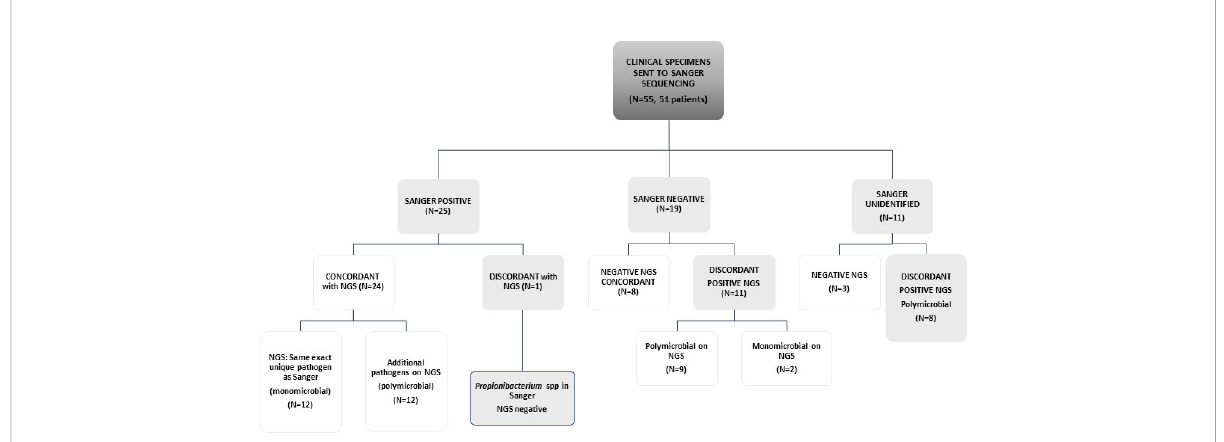
FIGURE 1 Concordance between Sanger sequencing and NGS in a scheme. Sanger negative are those samples that did not give any signal on PCR gels. "Sanger unidenti fi ed" are those samples that presented a band in agarose gels, but on Sanger sequencing it was not possible to de fi ne a unique organism against public databases.